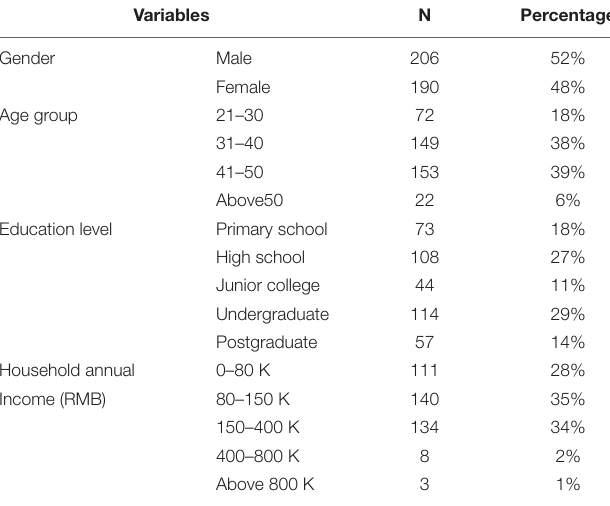
TABLE 1 | Demographic profile of